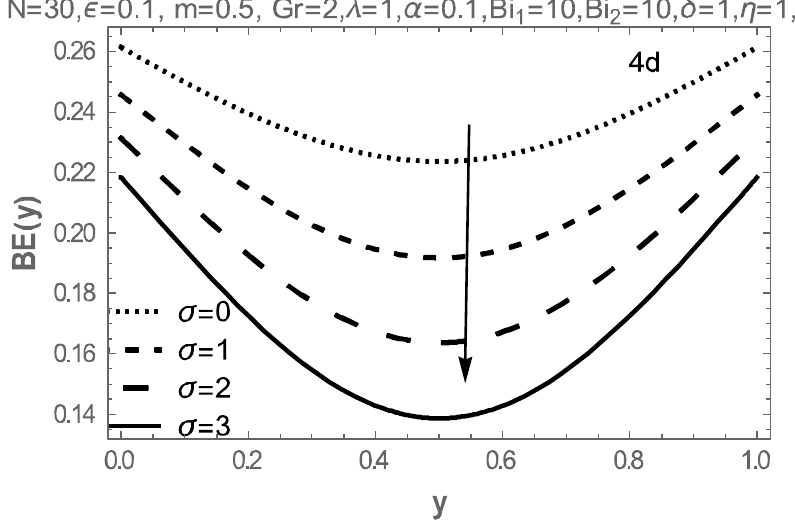
Figure 4. Variations in nonlinear Grashof number.